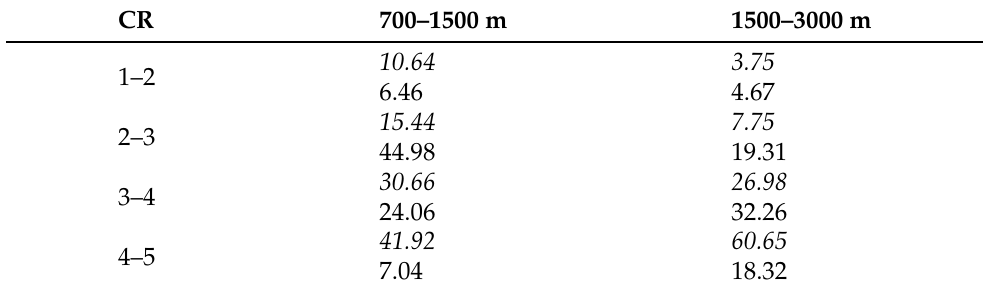
Table A5. Comparing the CR values of Müller (2018) of the 1–13 March 2018 with the data from this study, considering all available data for March 2019. The first value in each cell (in italic ) represents the data of Müller (2018), the second value represents the data found in this study. Note the fact that the values of this study do not sum up as 100%: this is because the data were filtered for clouds and those values have been left out, but have been included while calculating the relative